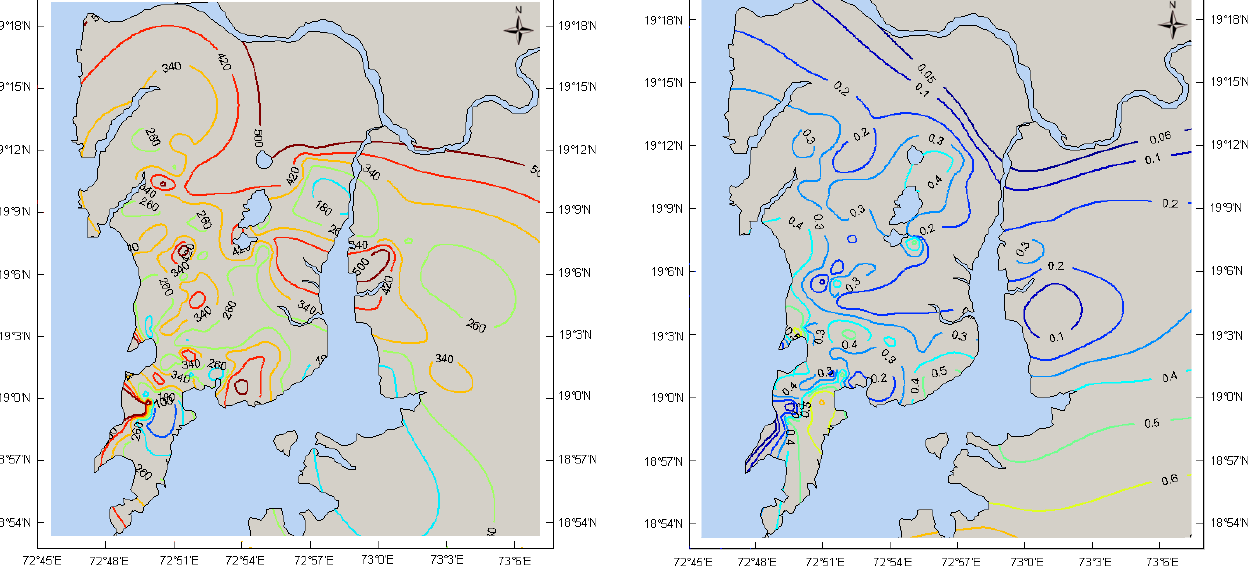
Fig. 3. Contour map of spatial distribution of site periods for Mum- bai